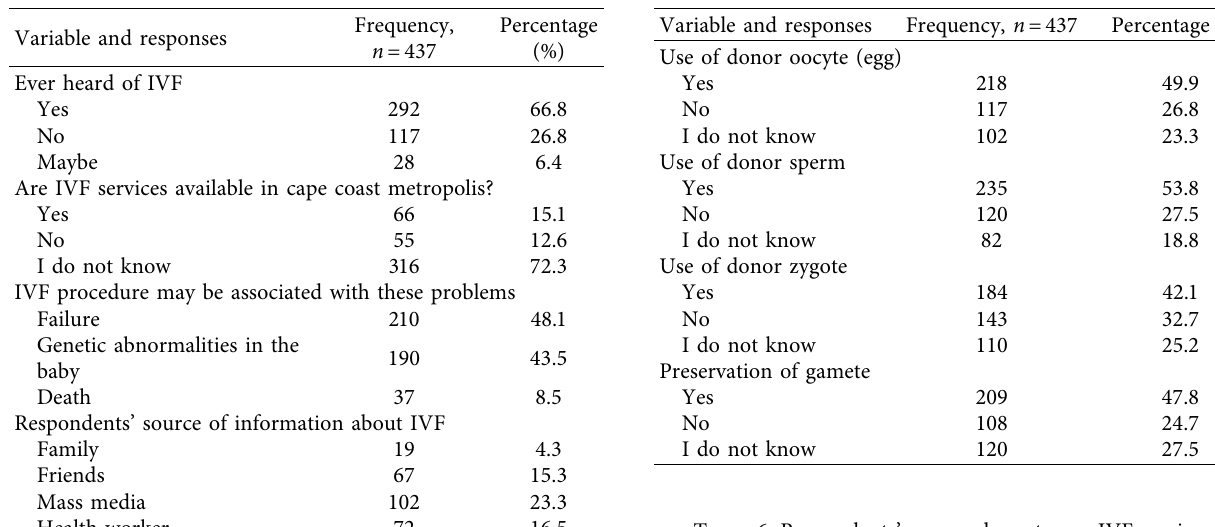
Table 5: These are forms of IVF services.